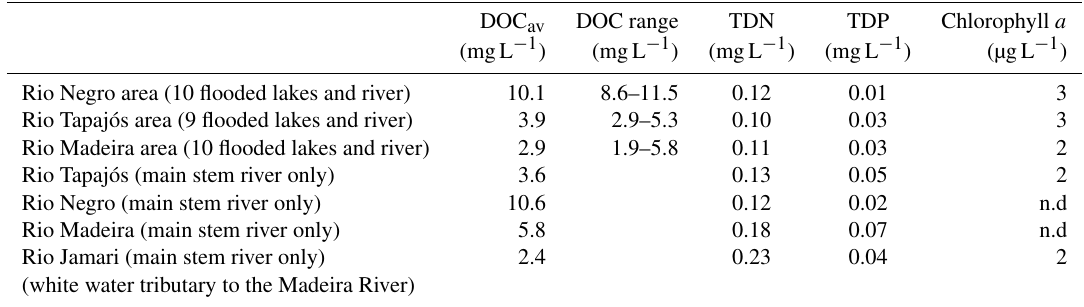
Table 2. Averaged nutrients, chlorophyll, DOC and TDN concentrations of all water samples collected in the main stem of the Rio Negro, Rio Madeira, Rio Jamari and Rio Tapajós as well as in 8–10 flooded lakes within the Rio Negro area, Rio Madeira area as well as within the Rio Tapajós and after its confluence with the Amazon River (Tapajós area) in May 2013. DOC av DOC range TDN TDP Chlorophyll a (mgL − 1 ) (mgL − 1 ) (mgL − 1 ) (mgL − 1 ) (µgL − 1 ) Rio Negro area (10 flooded lakes and river) 10.1 Rio Tapajós area (9 flooded lakes and river) Rio Madeira area (10 flooded lakes and river) Rio Tapajós (main stem river only) Rio Negro (main stem river only) Rio Madeira (main stem river only) Rio Jamari (main stem river only) 2.4 (white water tributary to the Madeira River) Note: DOC av denotes averaged DOC concentrations from each area. Standard error of DOC measurements was always between 0.1 and 0.2mg − 1 . TDN: total dissolved nitrogen; TDP: total dissolved phosphorus. n.d. denotes not detected. Standard errors of TDN and TDP were always between 0.001 and 0.0025mg − 1